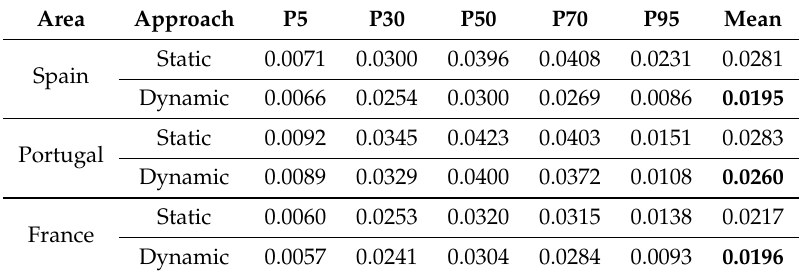
Table 7. Pinball loss function for weekly